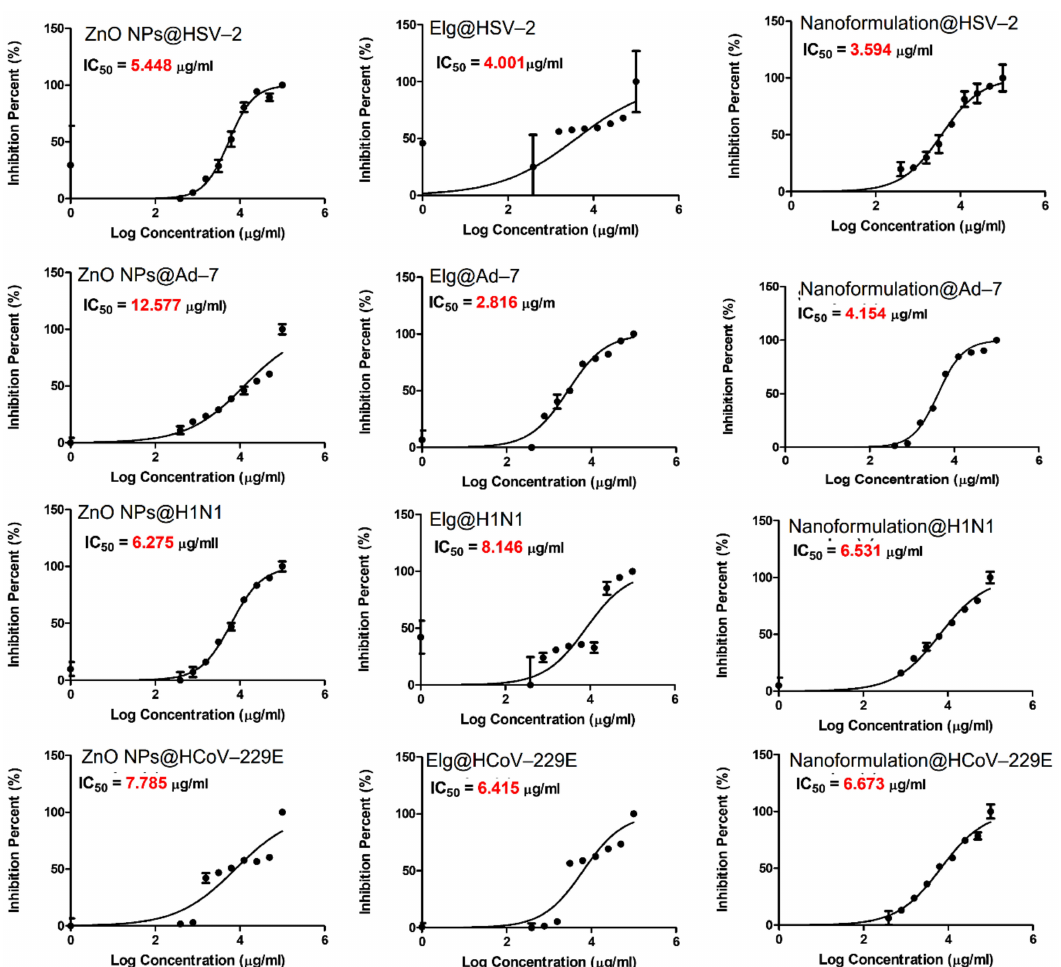
Figure 9. The antiviral effects (IC50) of tested materials against DNA and RNA viruses. DNA viruses were Ad-7 and HSV-2, and the RNA viruses were H1N1 and HCoV-229E. Each graph was obtained by nonlinear regression analysis. We plotted log concentrations against cell viability normalized